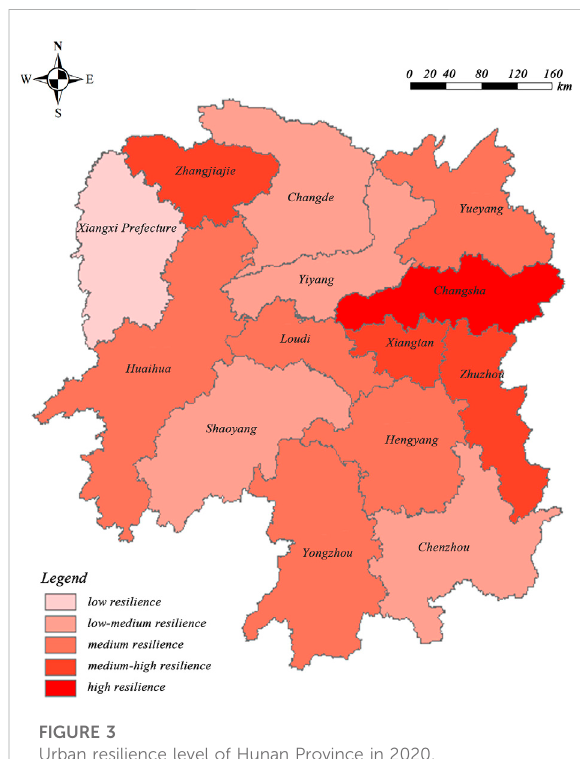
FIGURE 3 Urban resilience level of Hunan Province in